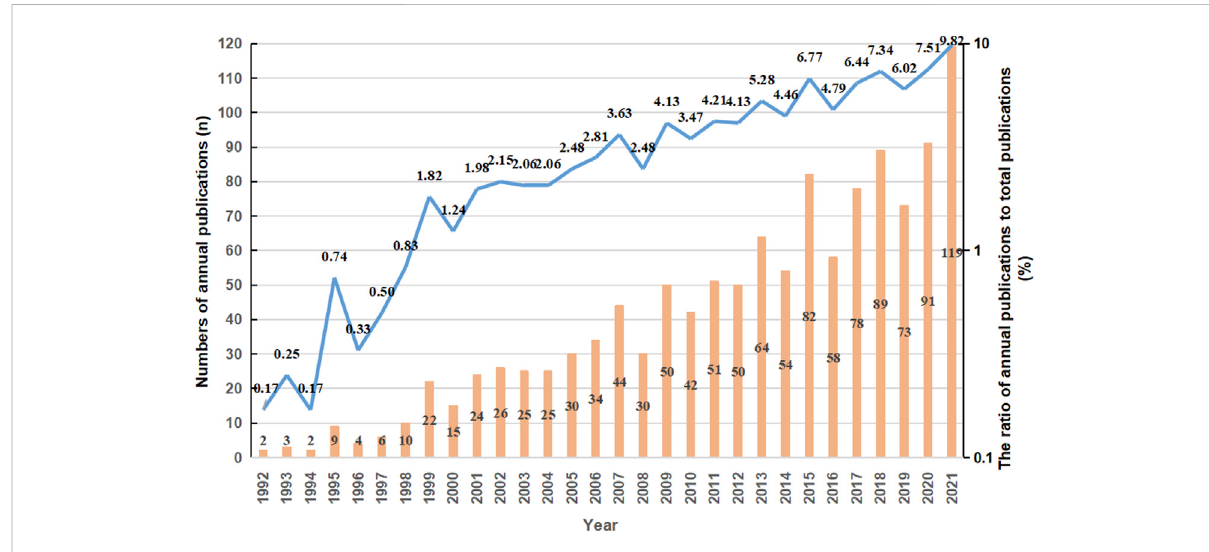
FIGURE 1 The annual number of publications and trend on sGC stimulators in cardiovascular research between 1992 and